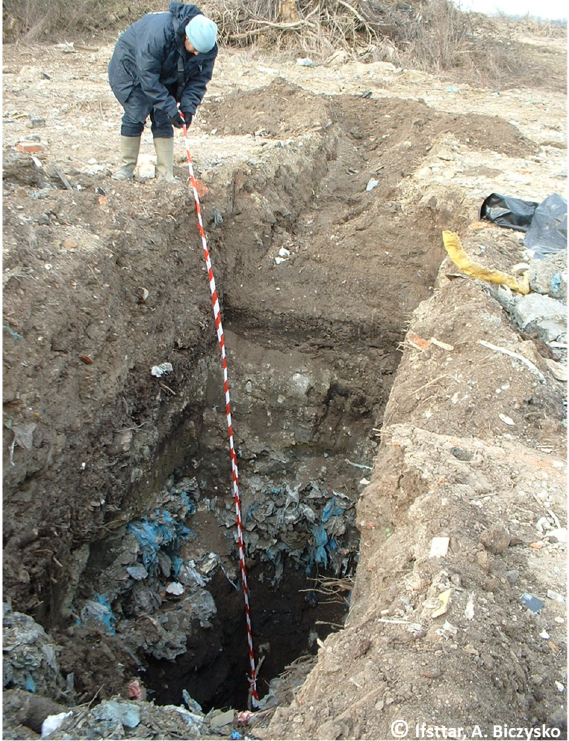
Figure 7. Picture of the excavations in the “Prairie de Mauves” waste deposit.